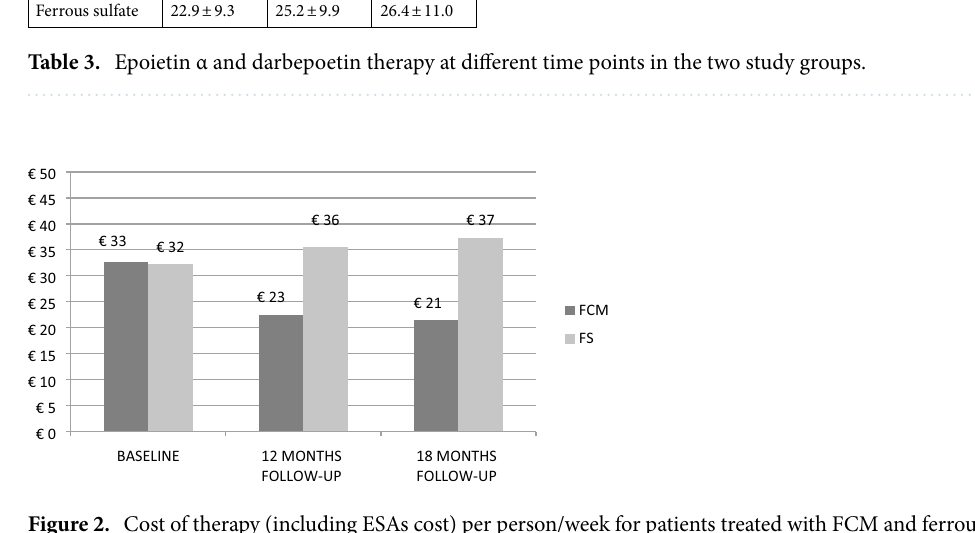
Figure 2. Cost of therapy (including ESAs cost) per person/week for patients treated with FCM and ferrous sulfate (FS) by time of